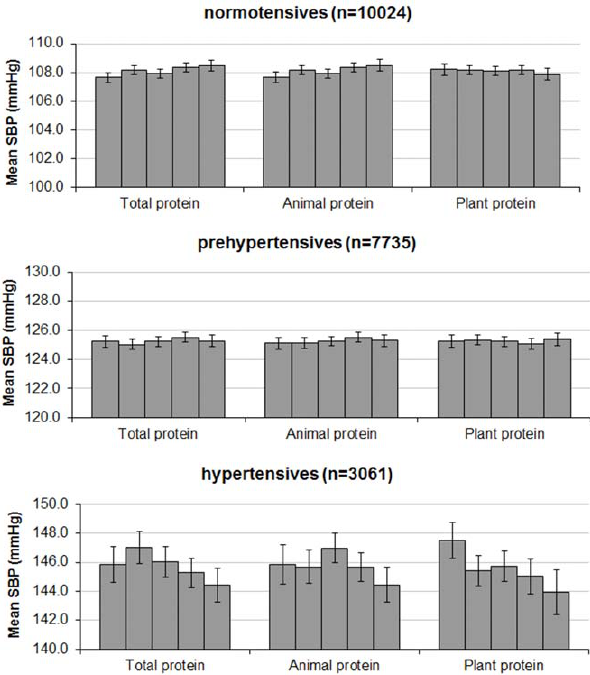
Figure 2. Systolic blood pressure in quintiles of protein intake, stratified by hypertension status. SBP=systolic blood pressure. p interaction for total protein=0.14, p interaction for animal protein=0.16, p interaction for plant protein= , 0.01. Values are average BP and 95% confidence interval, adjusted for age, gender, BMI, education, smoking, alcohol consumption, total energy, saturated fatty acids, carbohydrates, fiber, calcium, magnesium, potassium, and protein intake from other sources than the one under study, if applicable.